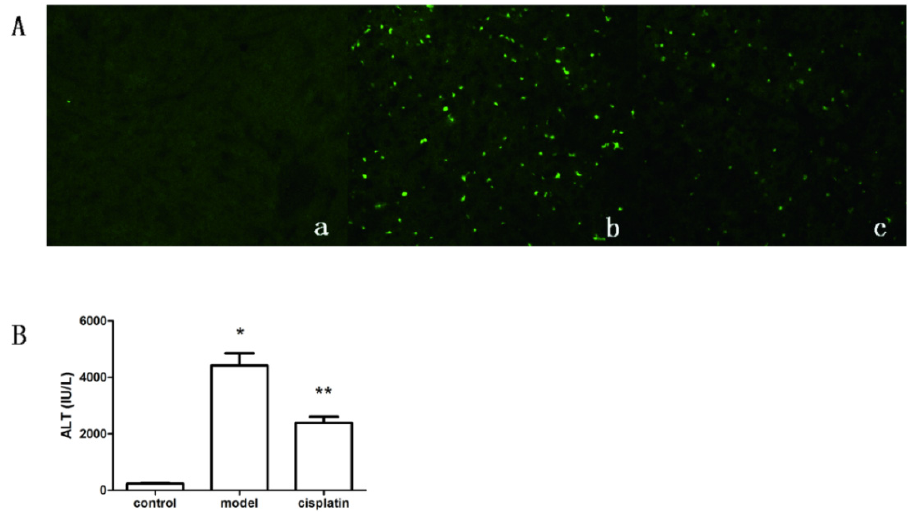
Figure 4. Effect of cisplatin on serum ALT levels and apoptosis in hepatic tissue.